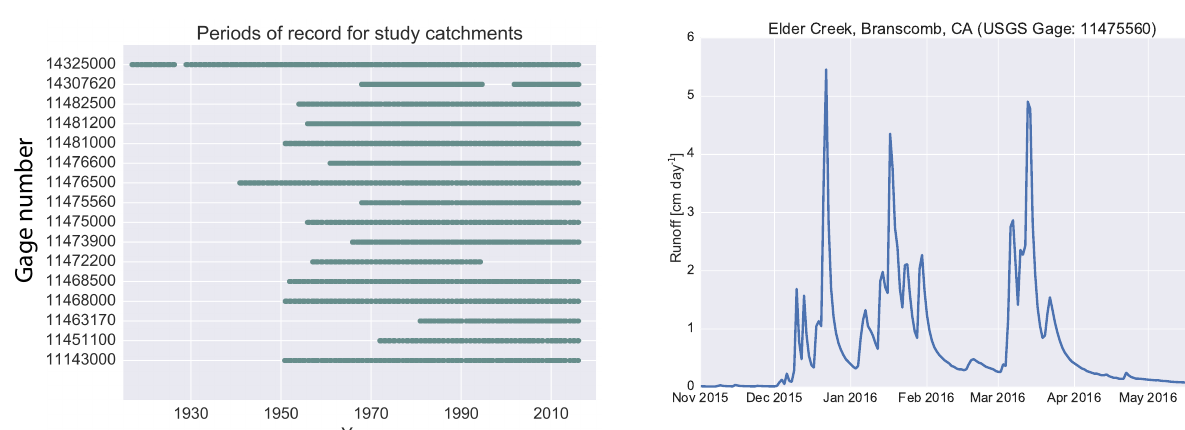
Figure 2. Typical, highly erratic runoff time series for northern Cal- ifornia coastal mediterranean